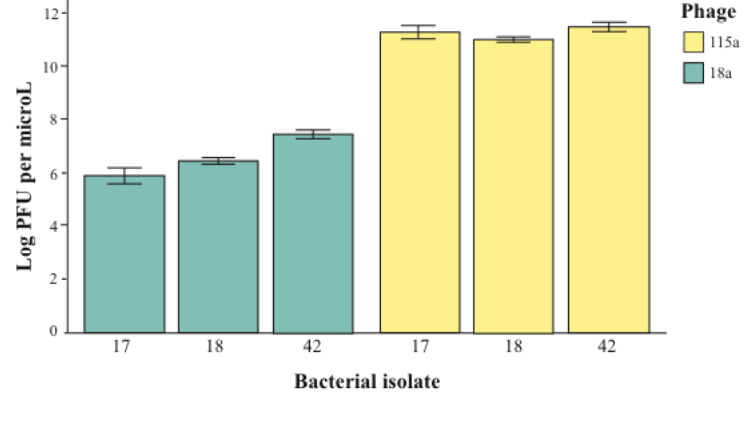
Figure 3. Results of the reciprocal cross-inoculation where the same phage inoculum was spotted in a dilution series onto lawns of each of three different Erwinia sp. bacterial isolates. The number of plaque forming units (PFUs) per microliter of inocula was measured for each cross, and the means across five replicates are shown on the Y-axis. Variation in PFU within a given inocula ( i.e. , among the blue bars or among the yellow bars) represents variation in phage success across bacterial hosts. Note that the important comparison is within-phage variation, as between-phage variation reflects absolute differences in phage